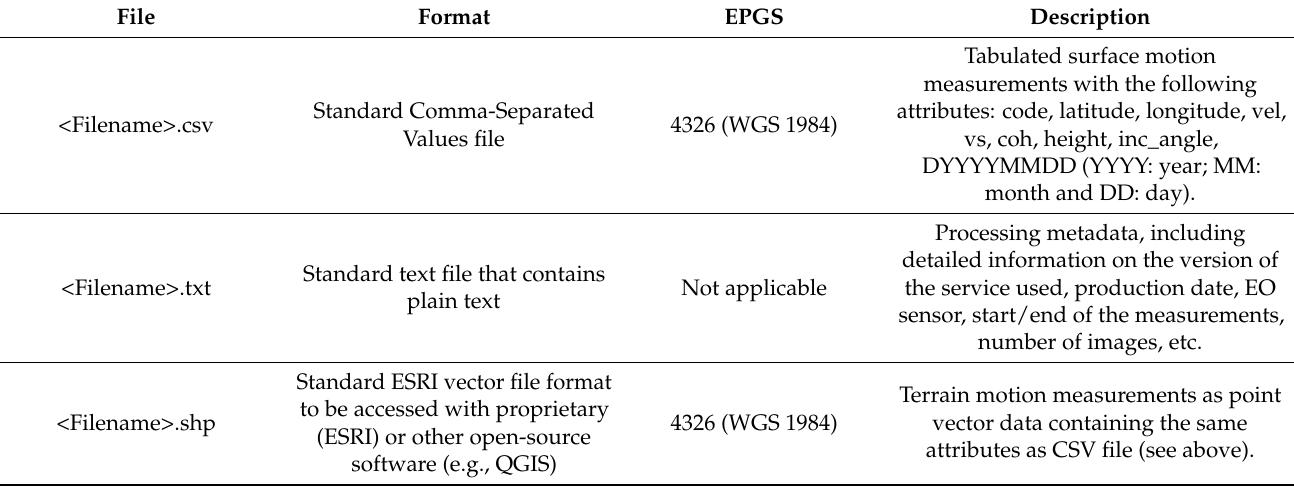
Table 1. List of outputs for SNAPPING PSI service (both Med and Full